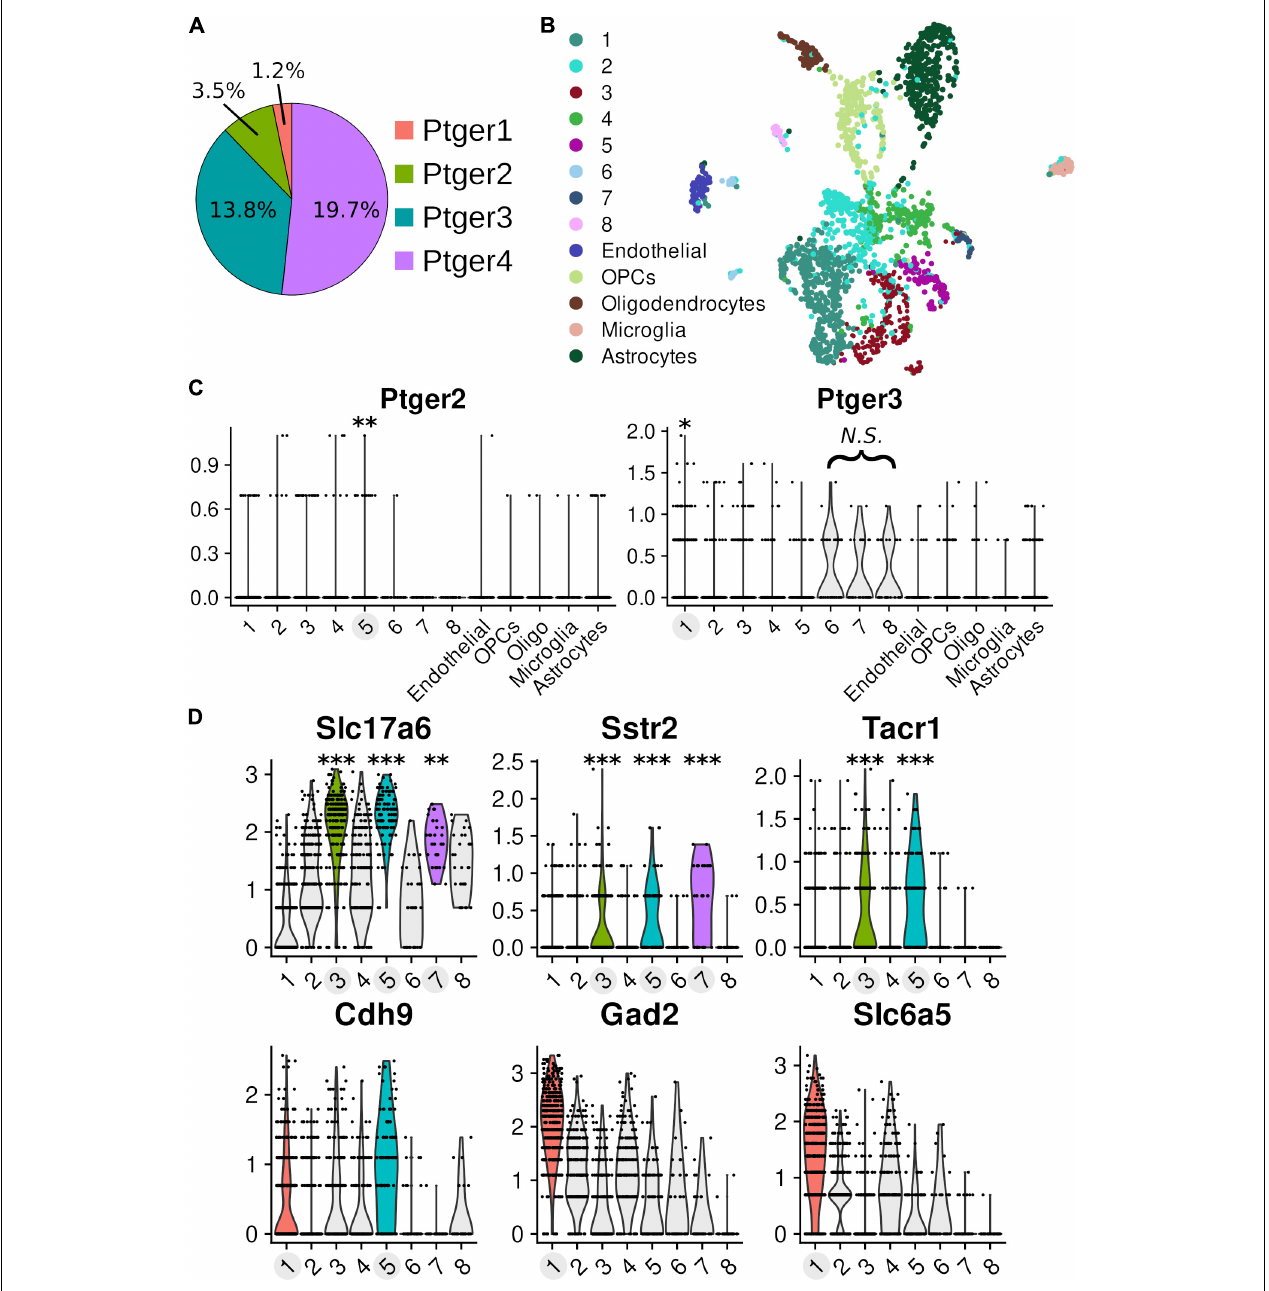
FIGURE 5 | Single-cell transcriptomics of pre-Bötzinger complex cells Transcriptomic data of 2119 cells from microdissected tissue punchouts targeted at the pre-Bötzinger complex ( n = 10, age post-natal day 4). On average, 11,247 unique molecules and 4,898 genes were detected per cell. Clusters with differential expression have labels highlighted in light gray and the associated violin distributions of significant expression are rendered in color. (A) Proportion of prostanoid receptor transcripts detected across all cells in the dataset: Ptger4 n = 418 cells, Ptger3 n = 292 cells, Ptger2 n = 73 cells, and Ptger1 n = 26 cells. (B) Dimensional reduction of the data in a 2D UMAP visualization, with the results of clustering into 13 groups overlaid by color. (C) Normalized expression values ( y -axis) for EP2 receptors ( Ptger2 ) and EP3 receptors ( Ptger3 ) across different clusters. Differential expression for Ptger2 in cluster 5 (log2 fold-change: 0.134, 12.4% of cells in cluster vs. 3.0% other cells, p = 0.00698). In cluster 1, there was differential expression for Ptger3 (log2 fold-change: 0.154, 21.3% of cells in cluster vs. 11.9% other cells, p = 0.0185) and Ptger4 (log2 fold-change: 0.267, 30.9% of cells in cluster vs. 17.0% other cells, p = 5.15e-6). (D) Markers for glutamatergic ( Slc17a6 ), GABAergic ( Gad2 ), and glycinergic ( Slc6a5 ) neurons. Markers that overlap with the core of the preBötC: SST receptors 2 ( Sstr2 ), neurokinin-1 (NK1R; Tacr1 ), cadherin-9 ( Cdh9 ) ( ∗ p < 0.05, ∗∗ p < 0.01, ∗∗∗ p < 0.001). See Supplementary Table 2 for values.